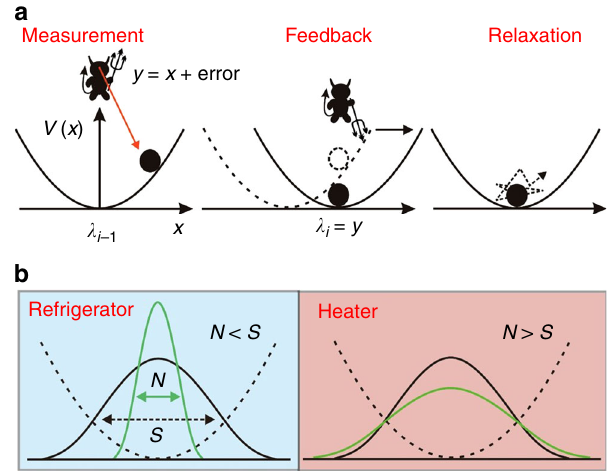
Fig. 1 Schematics of the mutual information-fueled colloidal engine. a Illustration of the i -th engine cycle. At the beginning of the i -th cycle, the particle is located at x with respect to the potential center λ i – 1 . The demon measures the particle position as y = x + error, with a Gaussian-distributed error of variance N . Basing on the measured y , the demon performs the feedback control step by instantaneously shifting the potential center to λ i = y . The particle is then allowed to relax for a time τ in the shifted potential until the next cycle begins. b Illustration of the noise-induced cooling and heating regimes. The system works as a refrigerator (heater) when N < S ( N > S ), where S is the variance of the equilibrium position distribution (solid black) and N is the variance of the noise distribution (solid